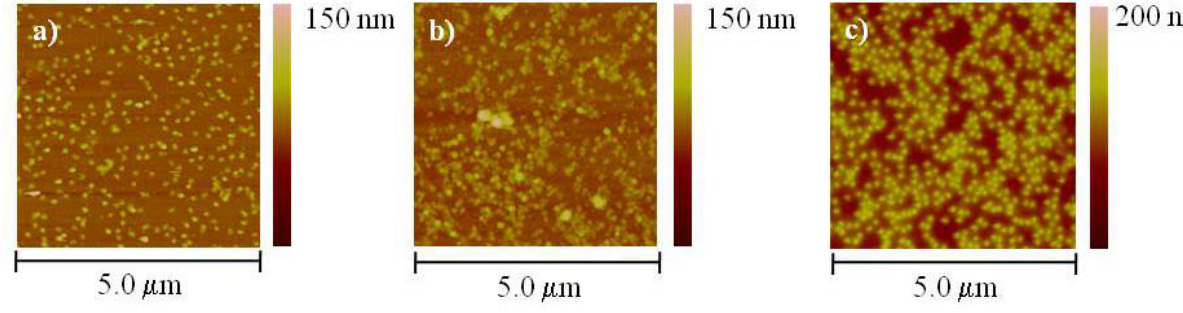
Figure 4 . Atomic force microscopy (AFM) topographical images of T4 nanoparticles deposited at a 1:10 dilution in 10 mM Tris-HCl at pH 8.8 on a) bare (clean) glass, b) aminosilanized glass and c) freshly cleaved